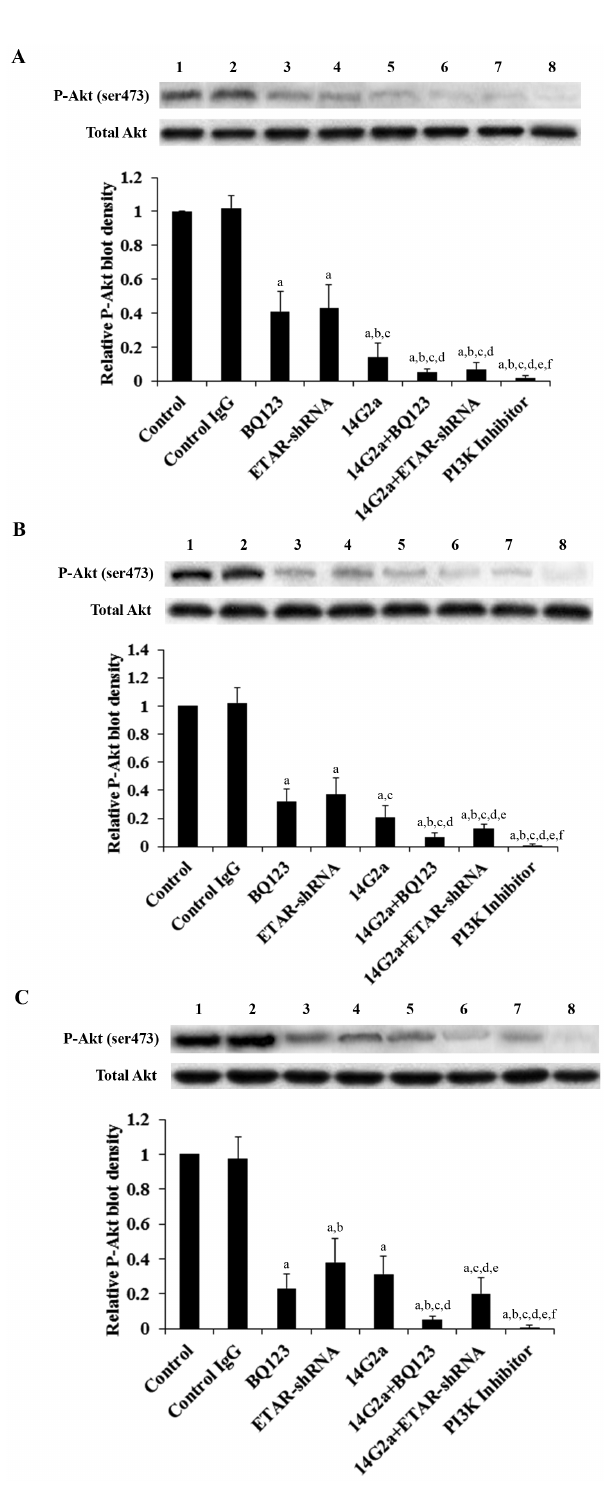
Figure 8. Effects of anti-ganglioside GD2 14G2a monoclonal antibody (mAb) alone or in combination with ET A receptor (ETAR) antagonist on phosphorylated Akt (P-Akt) level in osteosarcoma (OS) cells. Levels of total Akt and P-Akt at serine 473 (ser473) were determined by Western blot analyses in Saos-2 ( A ), MG-63 ( B ) and SJSA-1 ( C ) cells treated with control IgG (50 m g/mL, lane 2), selective ETAR antagonist BQ123 (5 m M, lane 3), stably-transduced ETAR-shRNA (lane 4), 14G2a mAb (50 m g/mL, lane 5), 14G2a + BQ123 (lane 6), 14G2a + ETAR-shRNA (lane 7), and selective